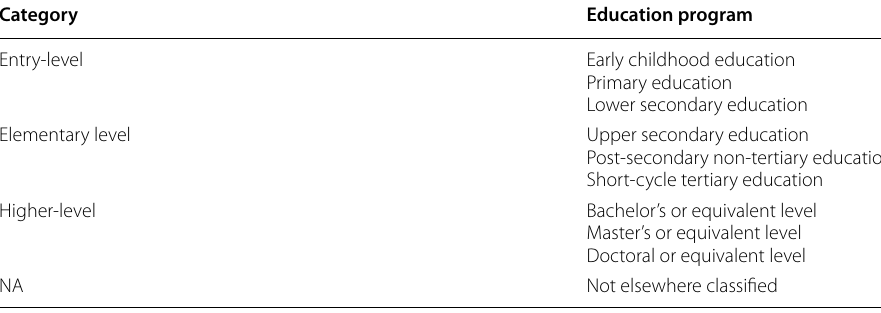
Table 3 Classification of